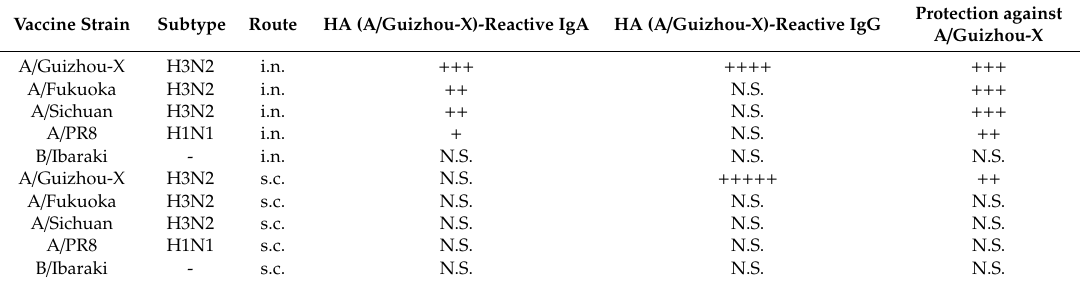
Comparison table of the e ffi cacy between intranasal (i.n.) and subcutaneous (s.c.) vaccines for influenza [98]. N.S., not significant. HA (A / Guizhou-X)-Reactive IgA in nasal wash; + , − 5 ng / mouse; ++ , 5–10 ng / mouse; +++ , 10–15 ng / mouse. HA (A / Guizhou-X)-Reactive IgG in nasal wash; ++++ , 20–25 ng / mouse; +++++ , 40–45 ng / mouse. Protection against A / Guizhou-X in nasal wash; N.S., approximately 1 × 10 4 EID 50 ; ++ , approximately 1 × 10 2 EID 50 ; +++ , approximately 1 × 10 EID 50 . (EID 50 , 50% egg infectious